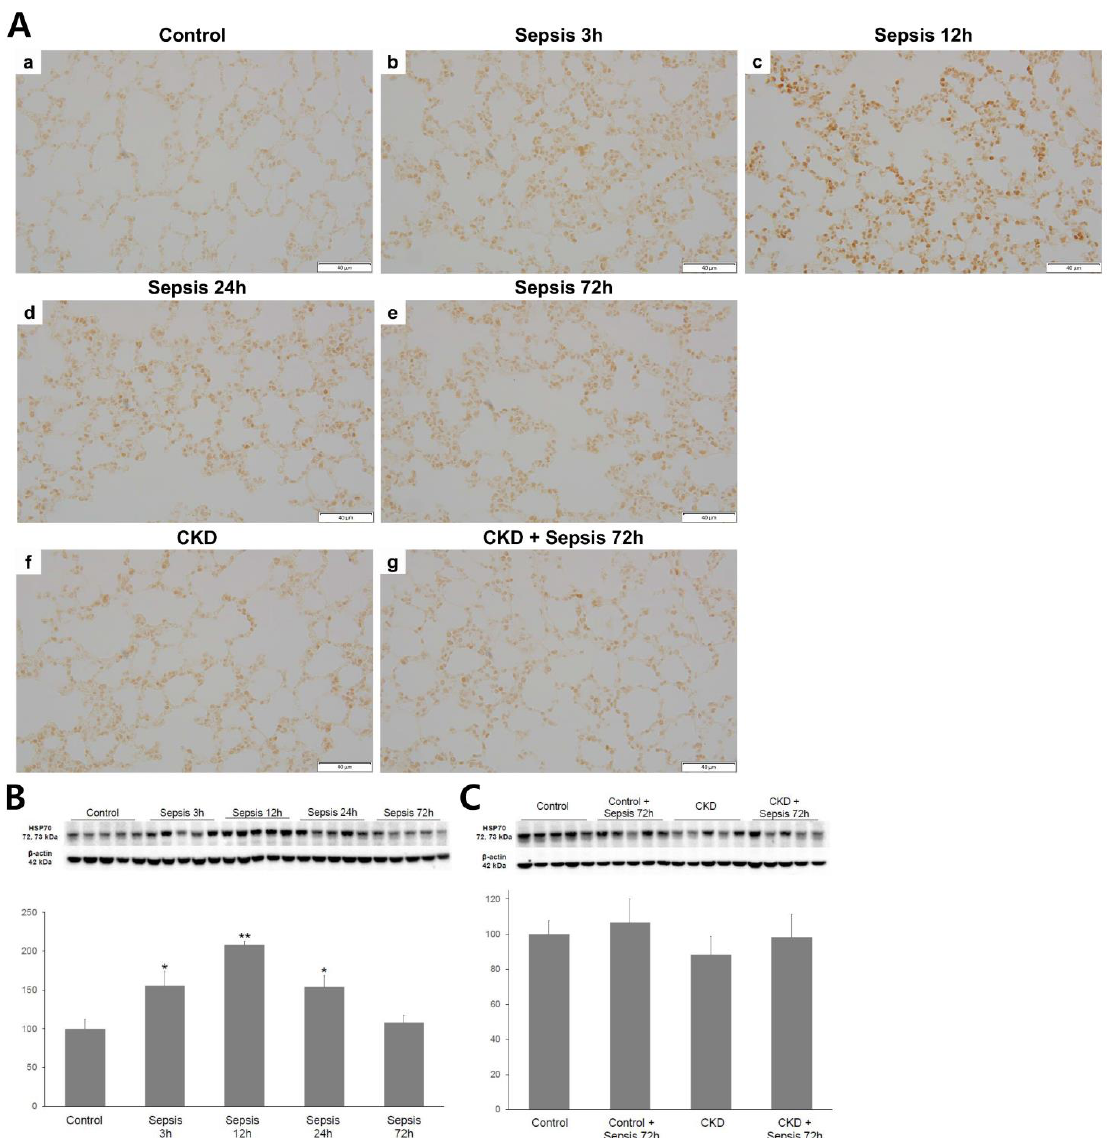
Figure 2. Heat shock protein (HSP) - 70 expression in the lung tissue: ( A ) immunohistochemistry of HSP - 70 in the lung tissue. Magnification, 400×; ( B , C ) Western blot for HSP - 70 expression in the lung tissue. Quantification of HSP - 70 was standardized based on β - actin expression in the lung: ( B ) in the control group, lung HSP - 70 expression was the highest at 12 h of sepsis; ( C ) enhanced lung HSP - 70 expression after sepsis induction was not observed in either group. Control, sham - operated model; sepsis model with 3, 12, 24, and 72 h after cecal ligation and puncture (CLP); CKD, chronic kidney disease (5/6 nephrectomized) model. * p < 0.05 versus control; ** p < 0.01 versus control. Error bars represent the standard error of the mean (SEM).